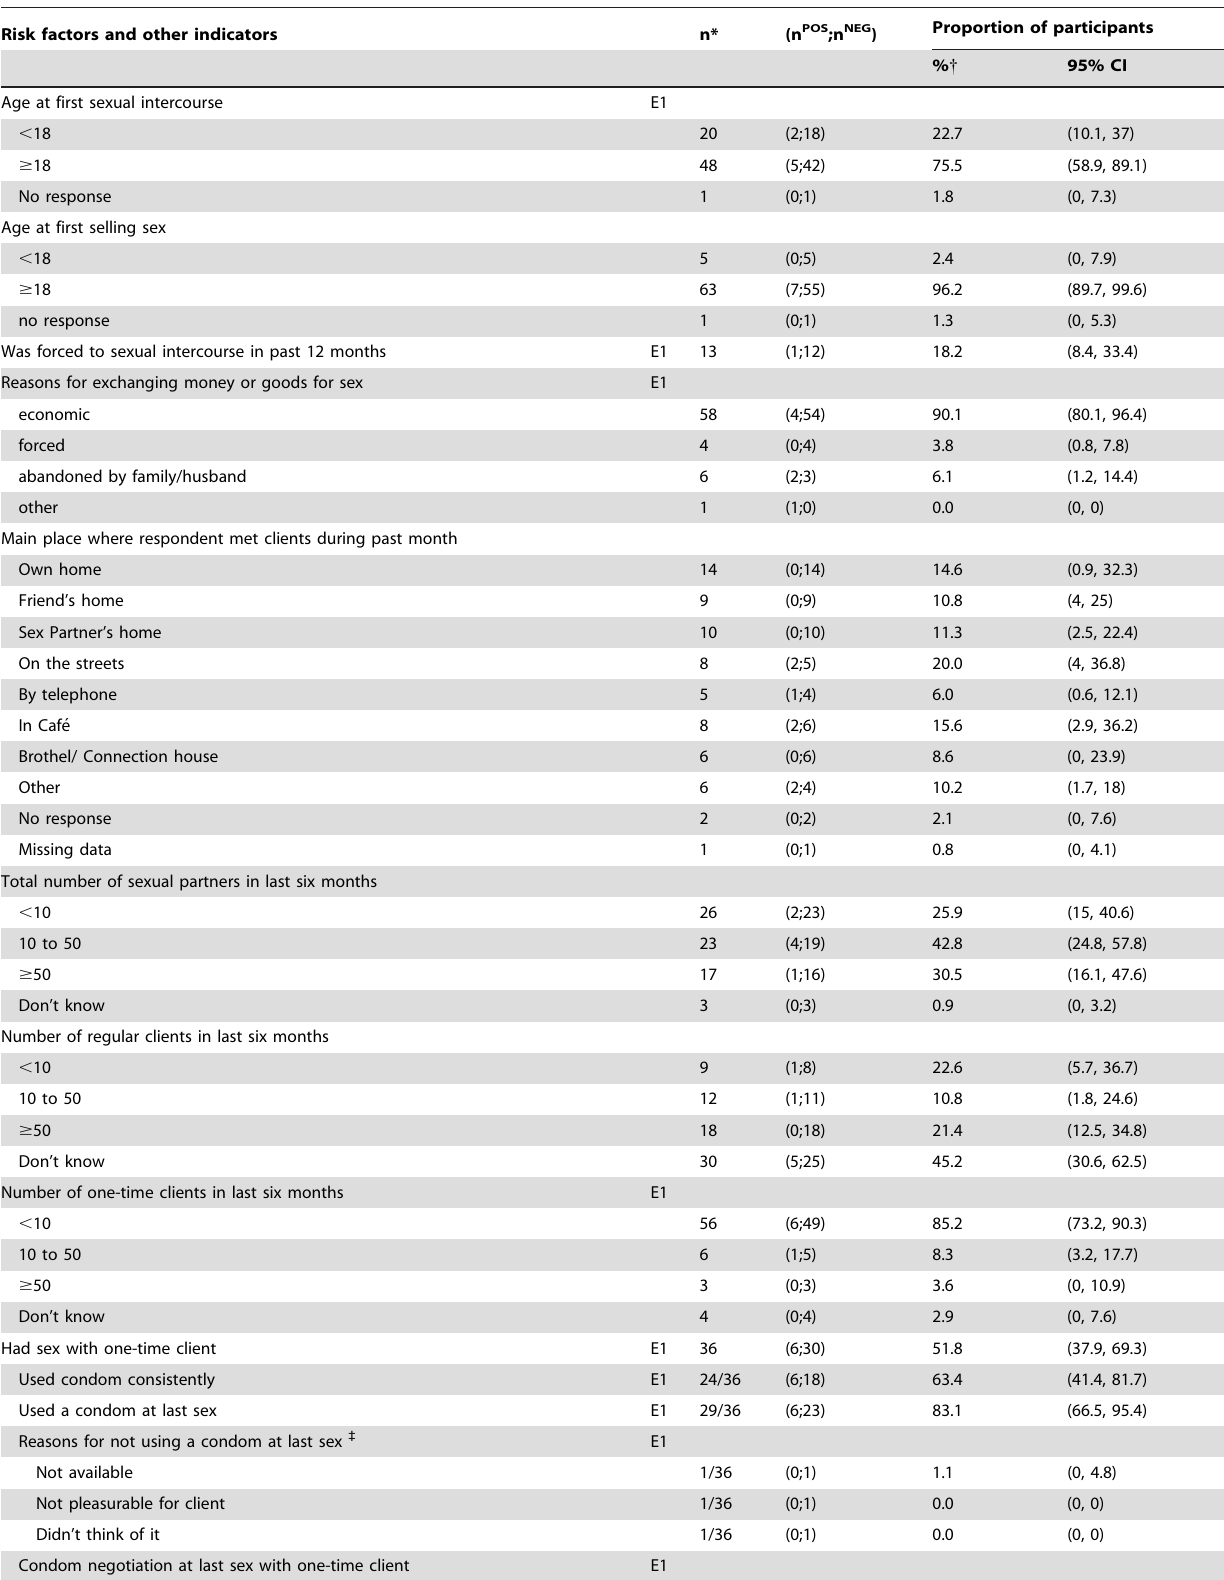
Table 3. Sexual behaviour and risk factors for HIV infection among FSW in Tripoli, Libya, 2010.